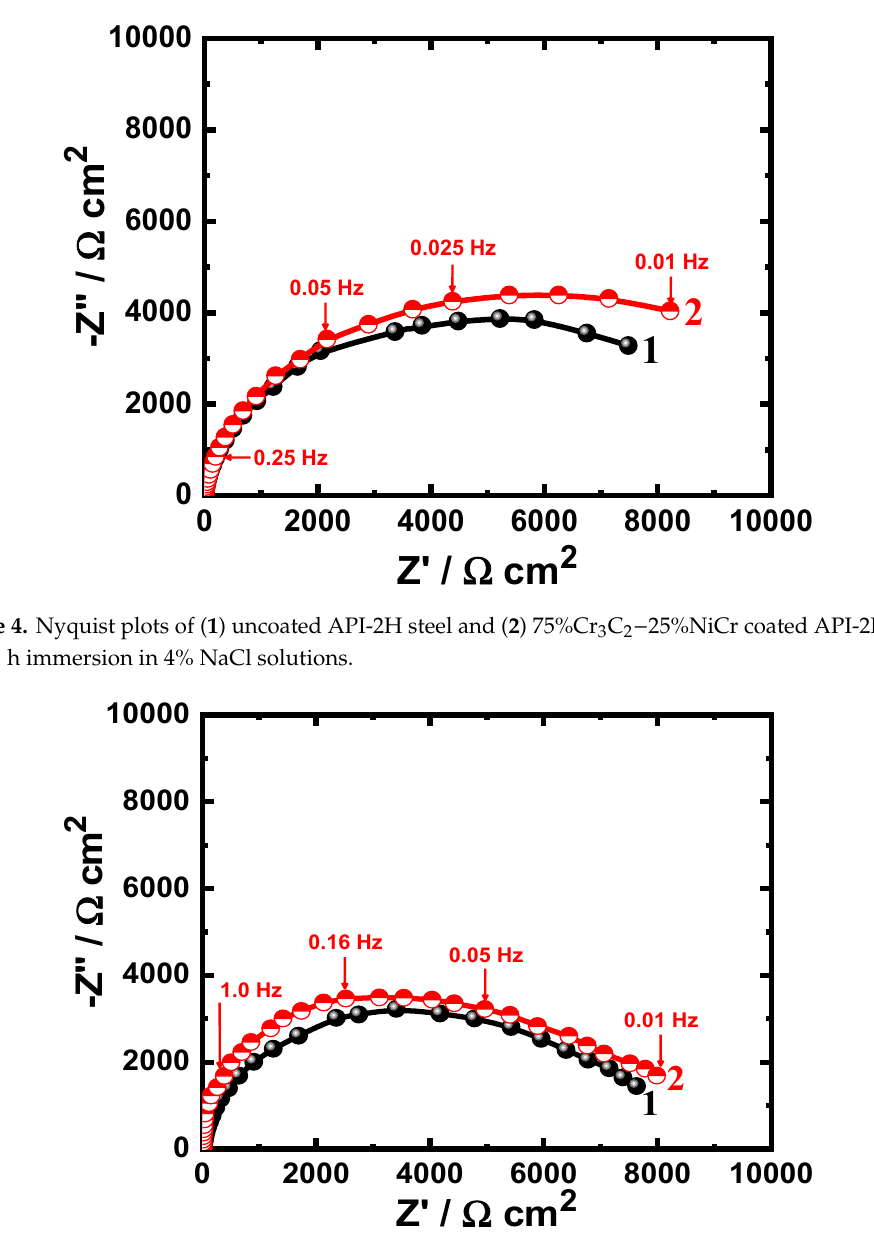
Figure 5. Nyquist plots of ( 1 ) uncoated API-2H steel and ( 2 ) 75%Cr 3 C 2 − 25%NiCr coated API-2H steel after 24 h immersion in the chloride solutions.